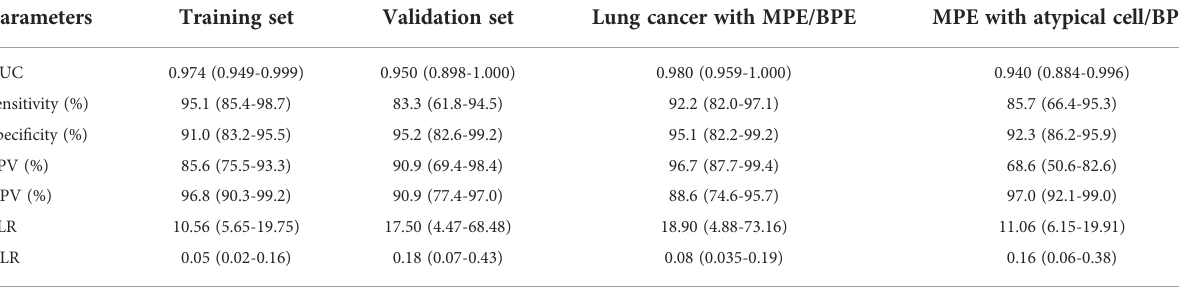
TABLE 4 Accuracy of the prediction score for differentiating MPE from BPE .